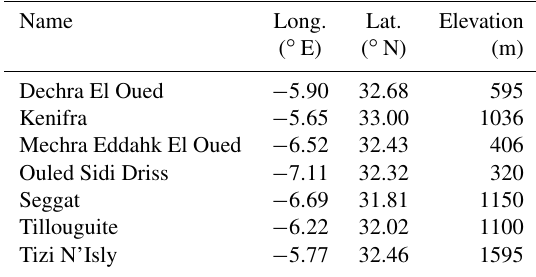
Table A1. List of precipitation